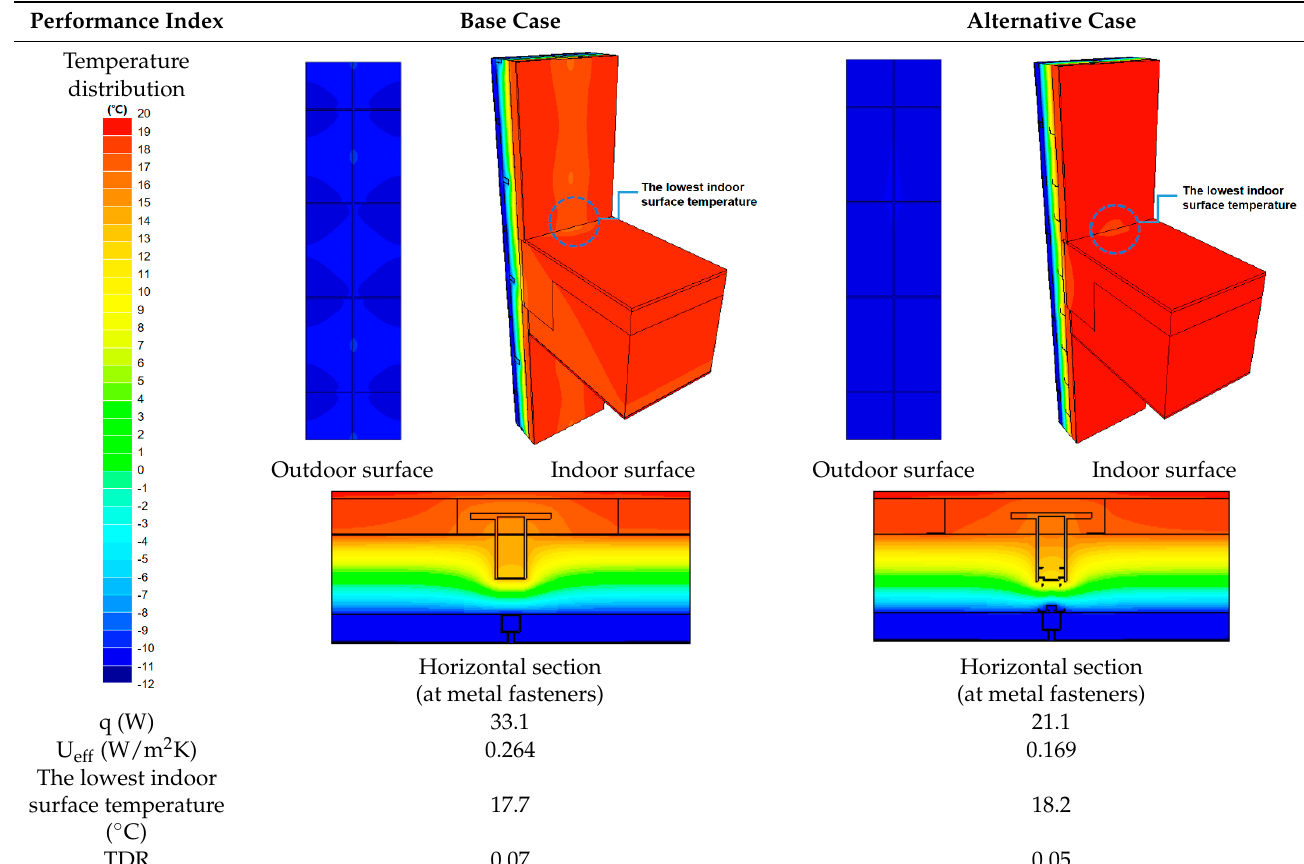
Table 3. Evaluation results of insulation performance by simulation.